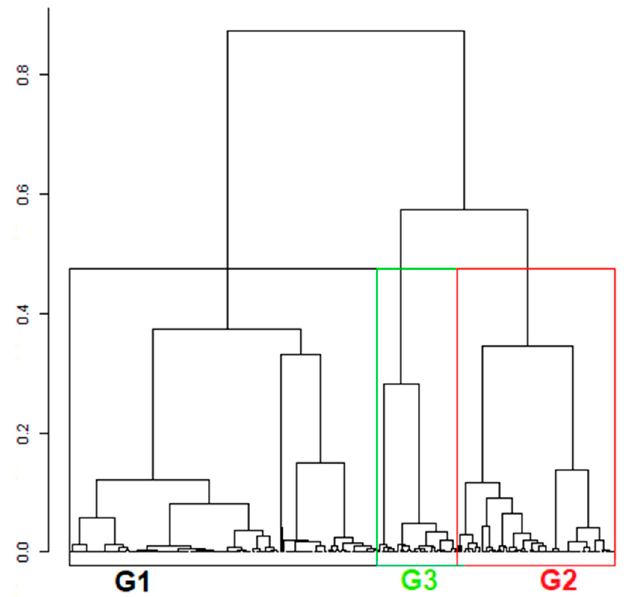
Figure 15. Graph showing the different groups of cocoa producer. Table 6. Summary of qualitative variables characteristic of the profile of infiltrators and cocoa plantations.